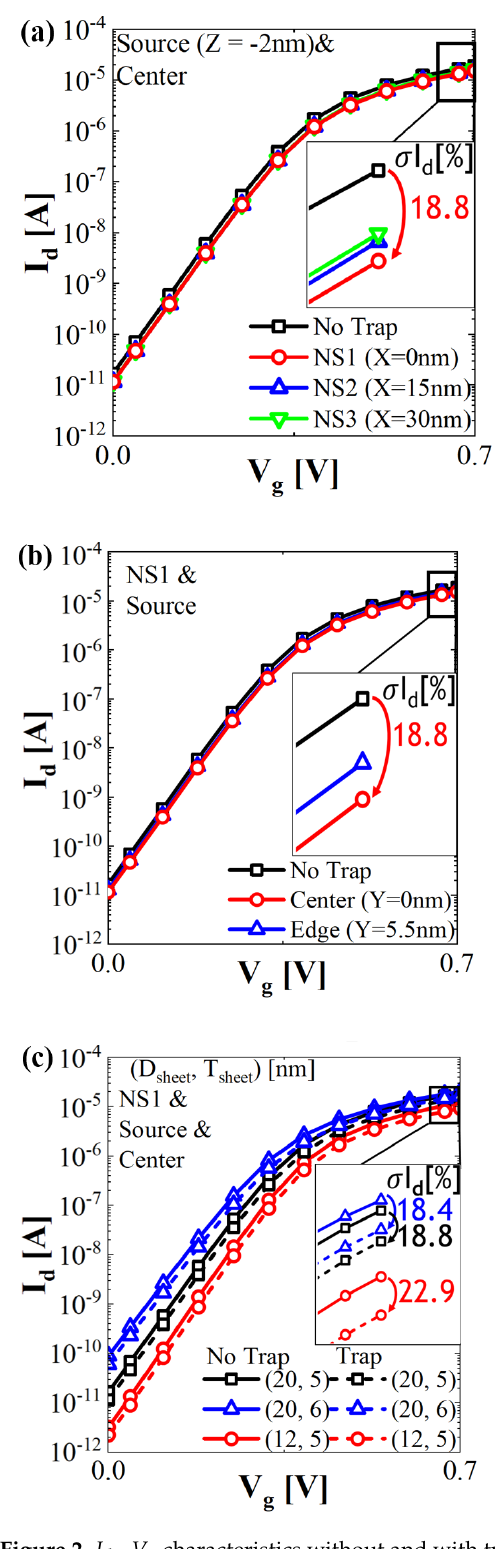
Figure 2. I d − V g characteristics without and with trap. ( a ) Different trap positions in various channel layers (X). ( b ) Different trap positions with regard to channel diameter direction (Y) in the NS1 layer. ( c ) Various diameters and thicknesses of channel. In the NS1 layer, trap location to channel length direction and sheet diameter direction are fixed at the source side and center, respectively.